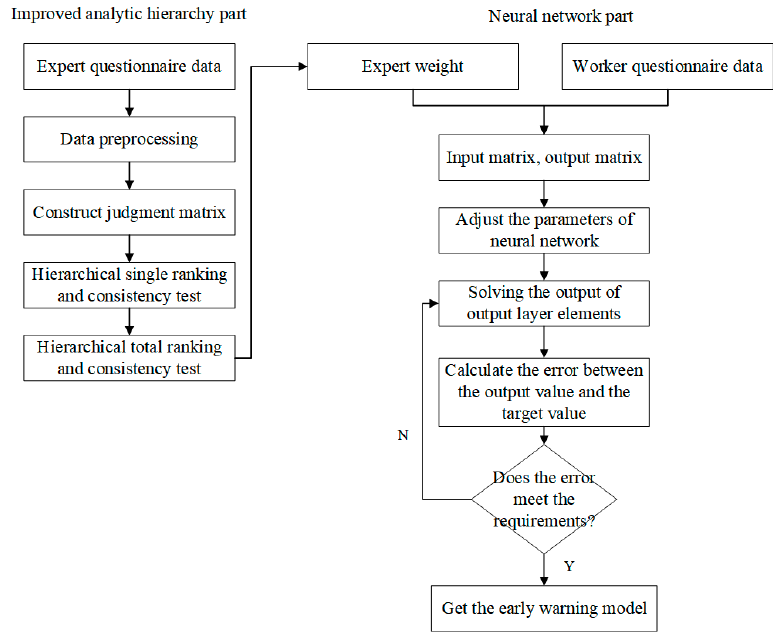
Figure 1. The specific research process.